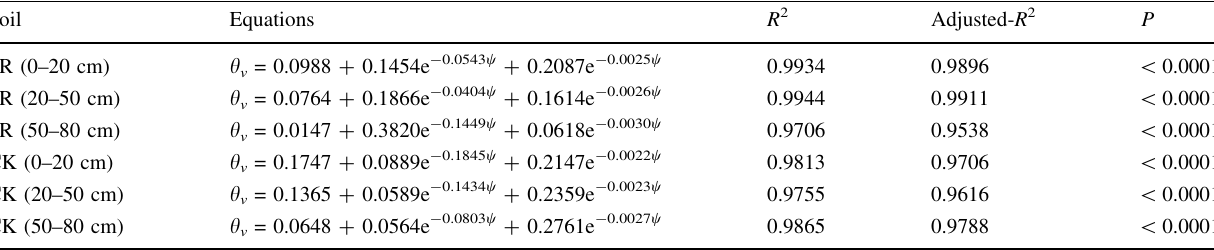
Table 2 Nonlinear regression equations of water characteristic curve of each soil layer of the reclaimed and unaltered farmlands Soil Equations R 2